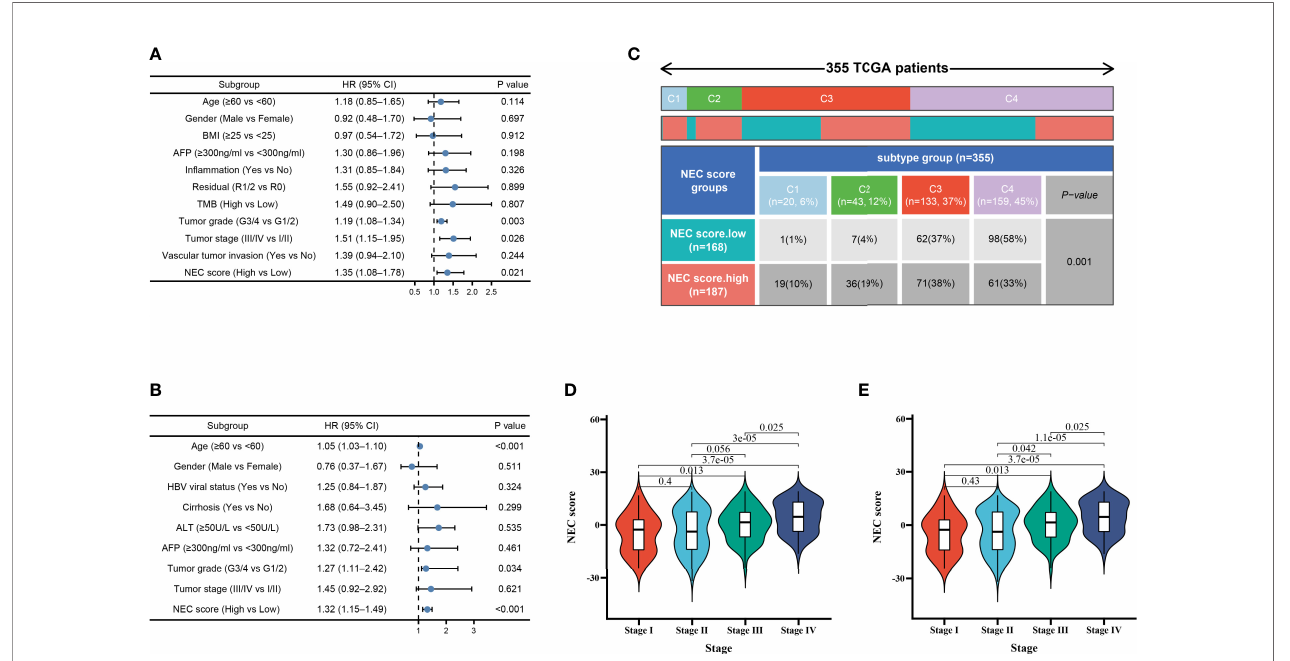
FIGURE 6 | Independent prognostic analysis of NEC score. (A) Multivariate Cox regression analysis for NEC score in TCGA cohort shown by the forest plot. (B) Multivariate Cox regression analysis for NEC score in GSE14520/NCI cohort shown by the forest plot. (C) Differences in NEC score between immune subtypes (C1: wound healing; C2: IFN-gamma dominant; C3: in fl ammatory; C4: lymphocyte depleted) (D) Differences in NEC score between different stage in TCGA cohort (Student ’ s t test). (E) Differences in NEC score between different stage in GSE14520/NCI cohort (Student ’ s t